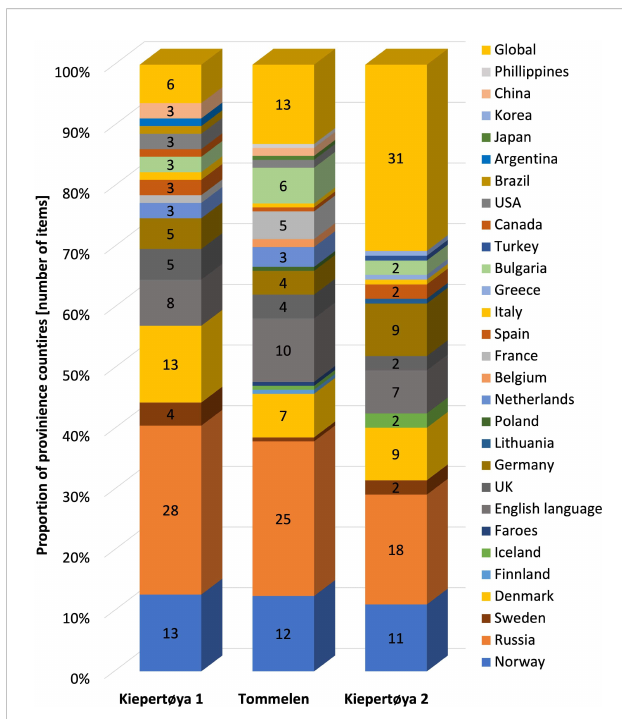
FIGURE 7 Proportions of marine debris of different provenance in three samples collected from Kiepertøya (2017), Tommelen (2019) and Kiepertøya (2021) from items that still showed signs of